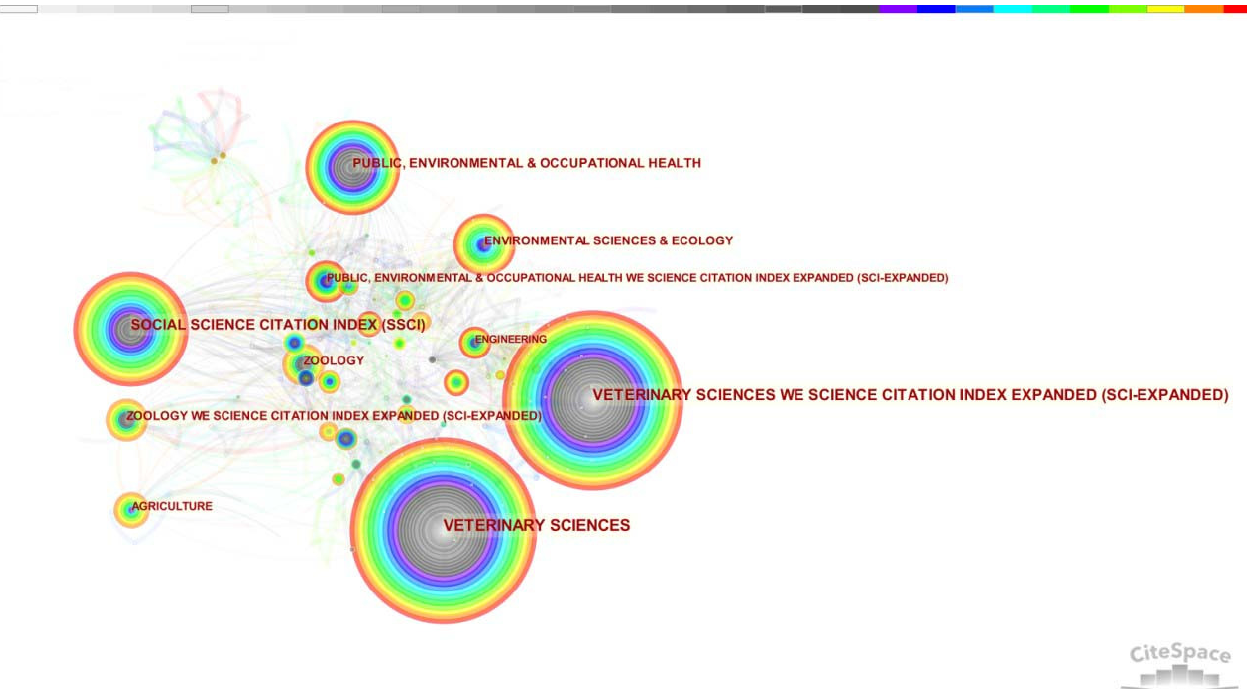
Figure 1. Disciplinary distribution structure of the research (one-year time slices with older data in “cooler” colors and newer data in “warmer” colors).